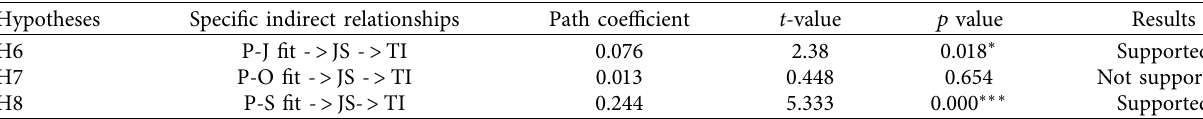
Table 6: Mediating effect of job